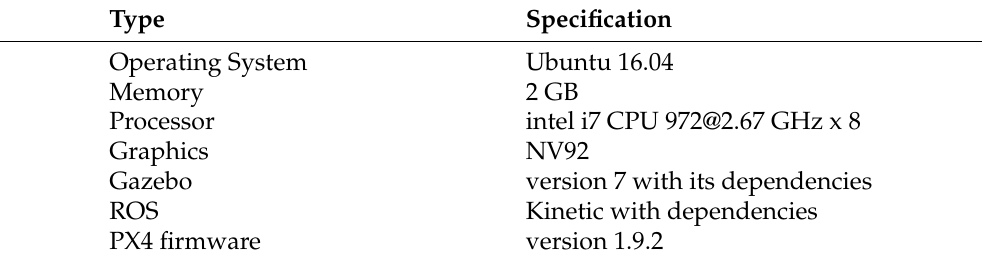
Table 1. Desktop Computer specification and software used for